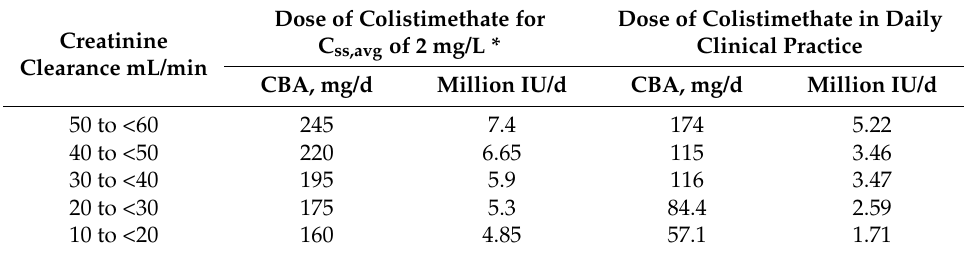
Table 2. Table daily doses of colistimethate for a desired target colistin C ss of 2 mg/L compared with the mean daily doses used in daily clinical practice for different creatinine clearances. Dose of Colistimethate for Dose of Colistimethate in Daily Creatinine C ss,avg of 2 mg/L * Clinical Practice Clearance mL/min CBA, mg/d Million IU/d CBA, mg/d Million IU/d 50 to <60 245 7.4 174 5.22 40 to <50 220 6.65 30 to <40